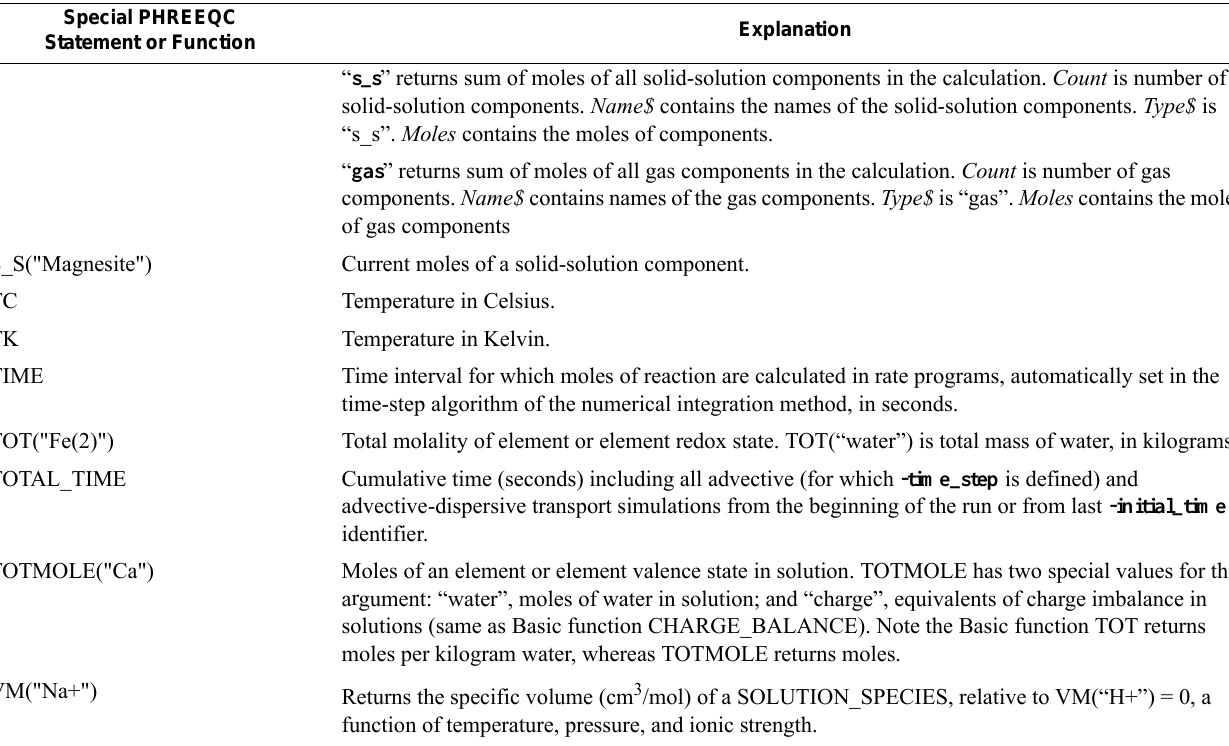
Table 8. Special Basic statements and functions for